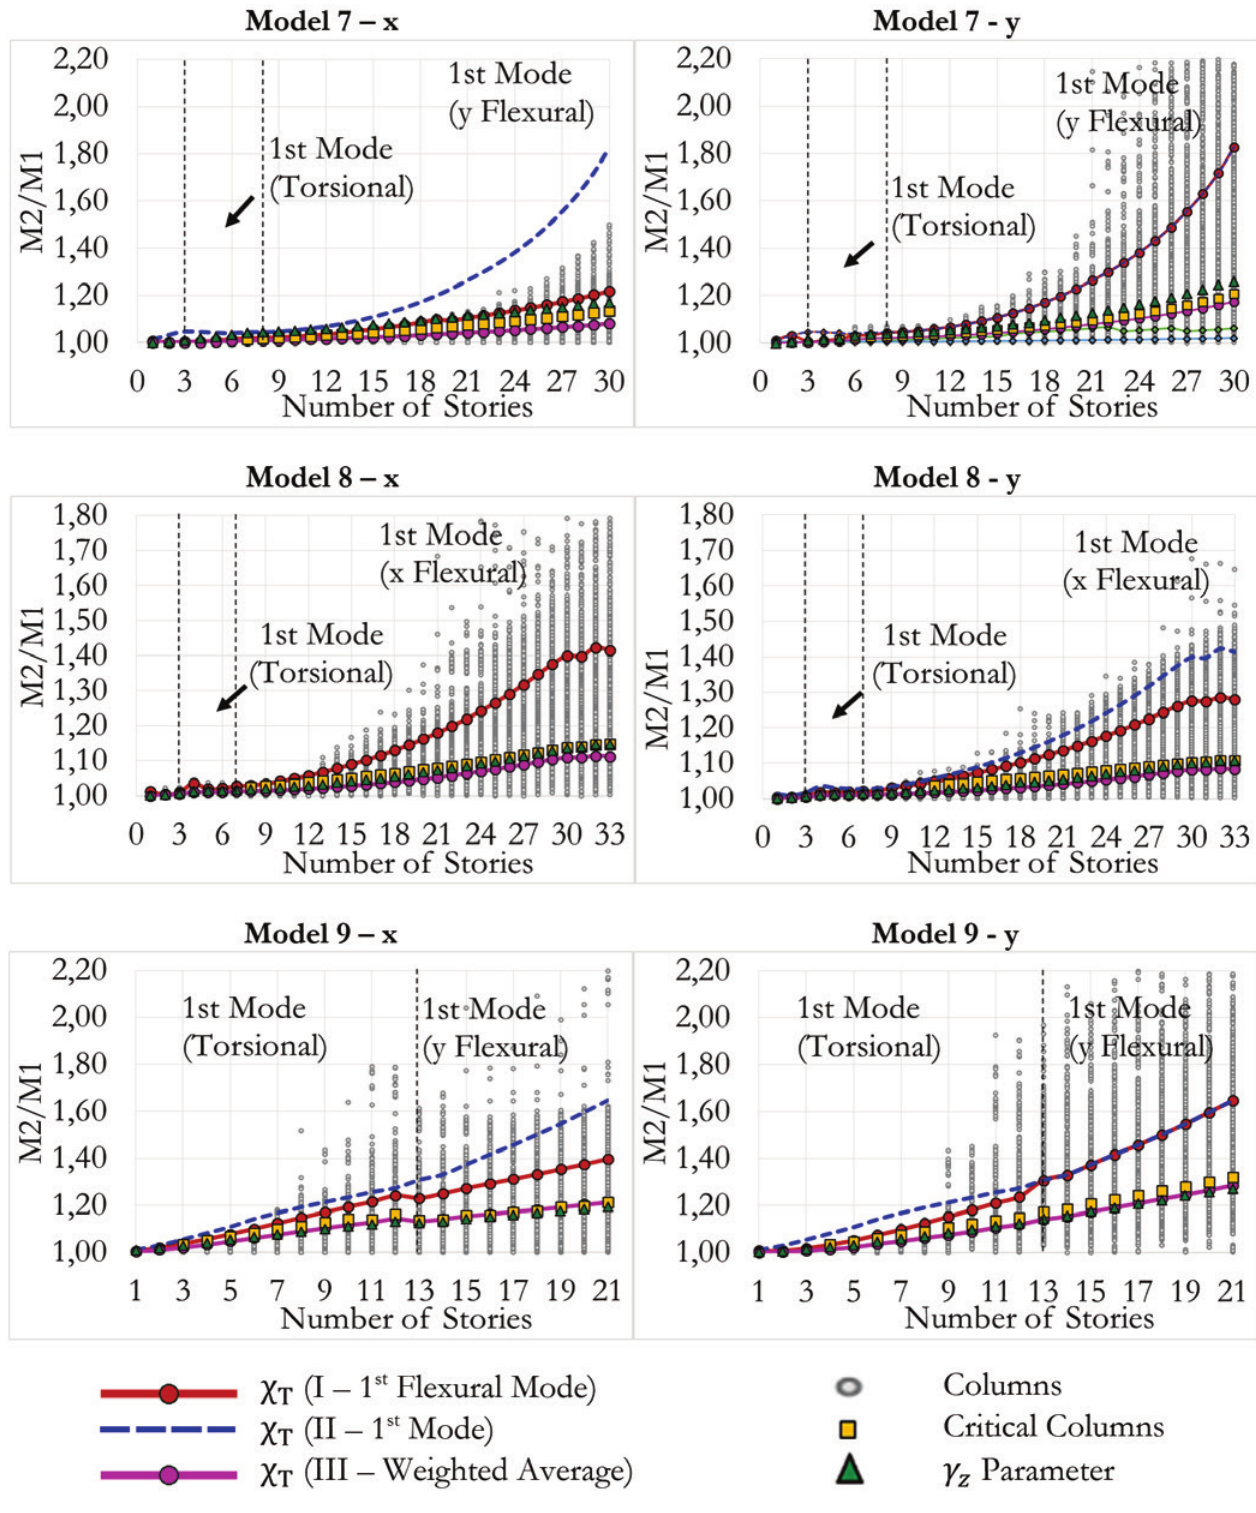
Moment amplification M Models 7, 8,